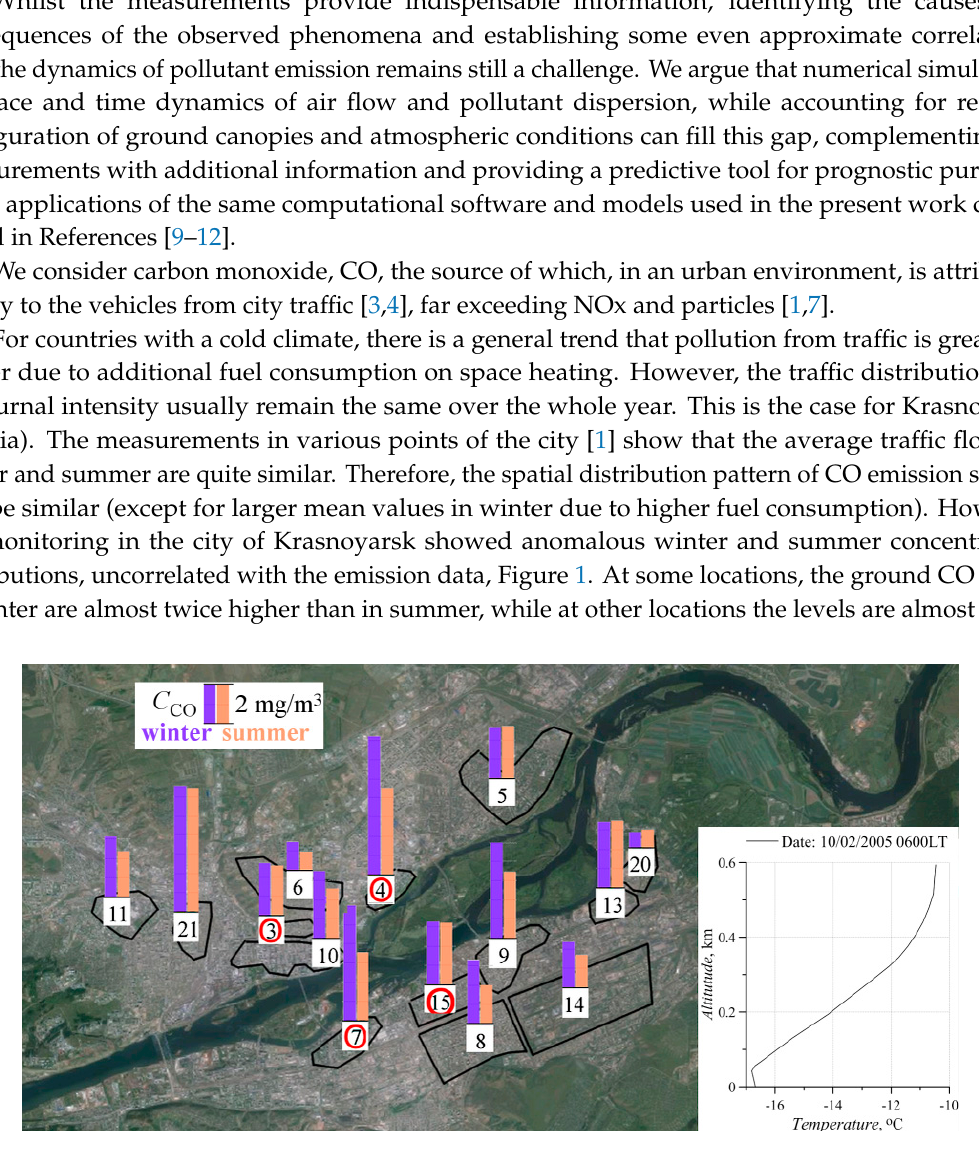
Figure 1. Measured CO concentration in different parts of the Krasnoyarsk city in the winter and in the summer seasons (data from Reference [1]), black lines indicate the measurement zones. Inset: A typical observed winter morning inversion in the area (data from Reference [8]).